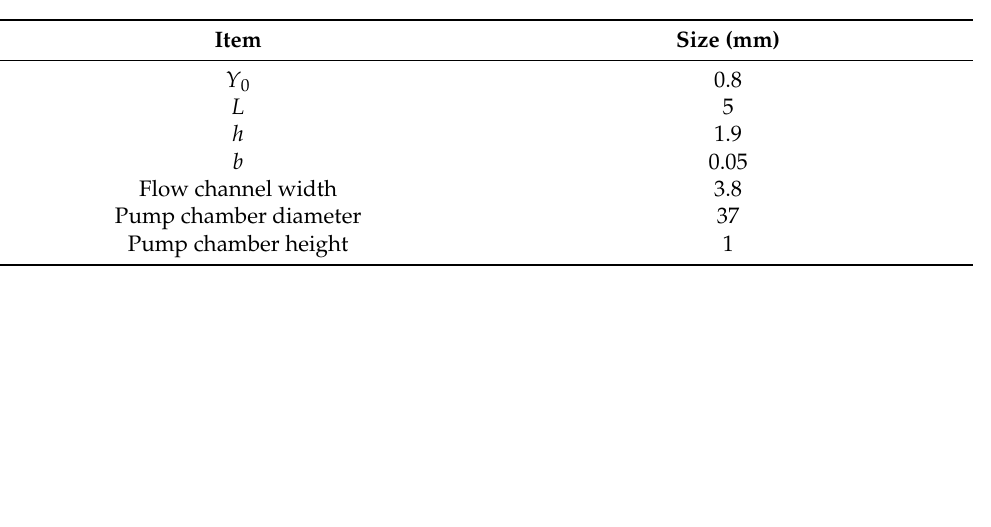
Table 1. The size of the